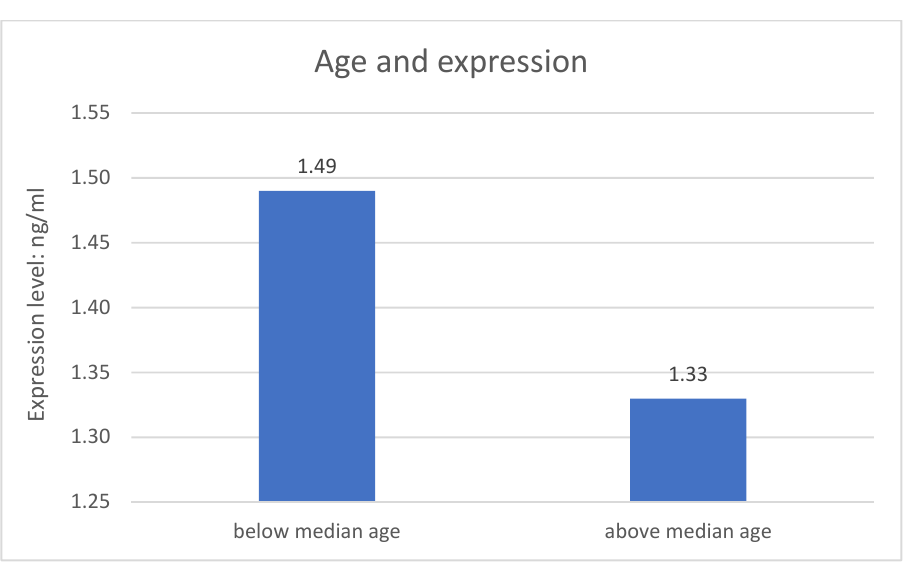
Figure 2. Age and expression of the studied gene.